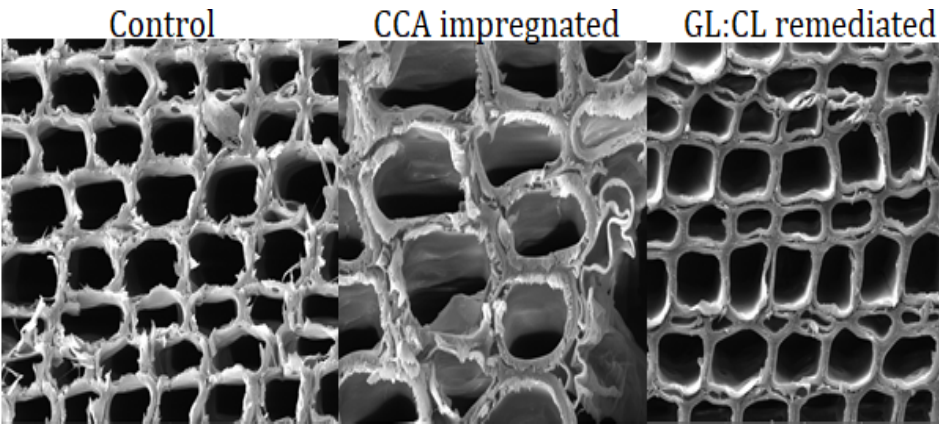
Figure 1. SEM analysis results of test and control samples.